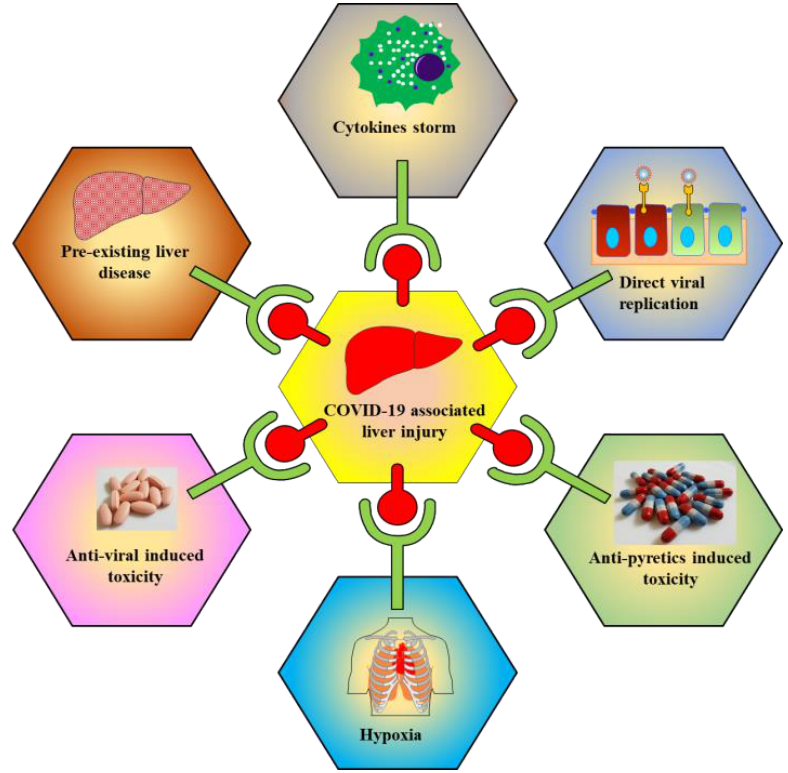
Figure 3. Schematic representations show multiple factors are responsible for COVID-19 associated liver toxicity/injury. Factors include cytokine storm, direct viral replication, antipyretics induced toxicity, hypoxia, antiviral induced toxicity, and pre-existing liver